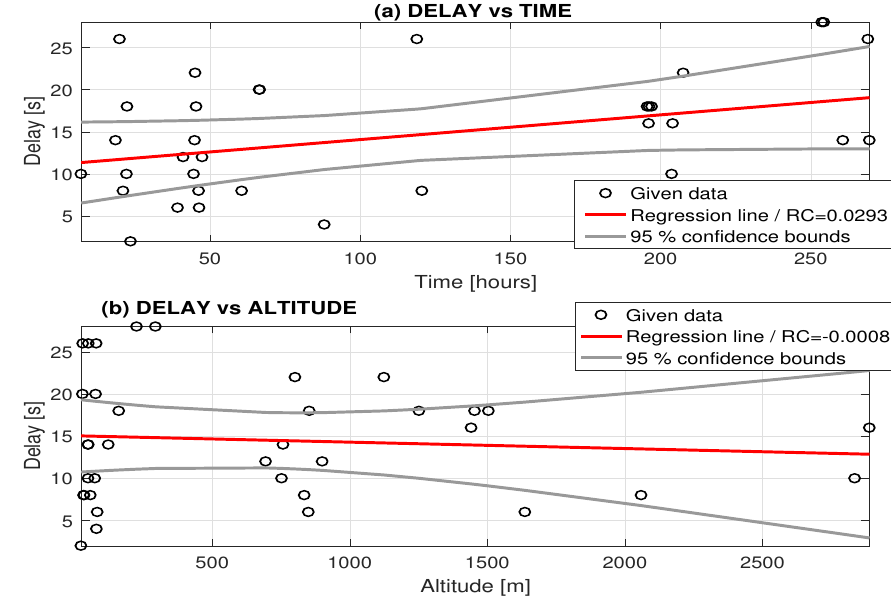
Figure 7. The delay of the change in the heart rate with gradient of altitude for uphill cycling in 10-min segments and correlation coefficients larger than 0.4, presenting its evolution ( a ) in time, owing to the increasing fitness level; and ( b ) with the altitude, owing to climate conditions.